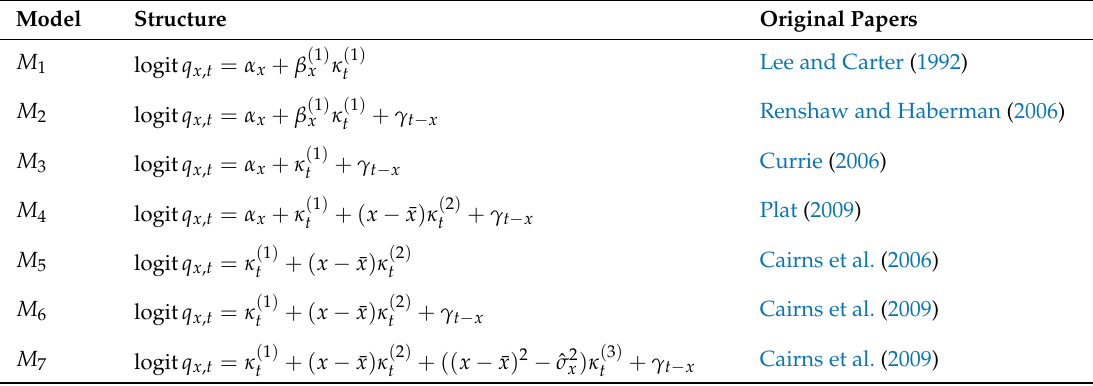
Table 1. Structure overview of mortality models used in this